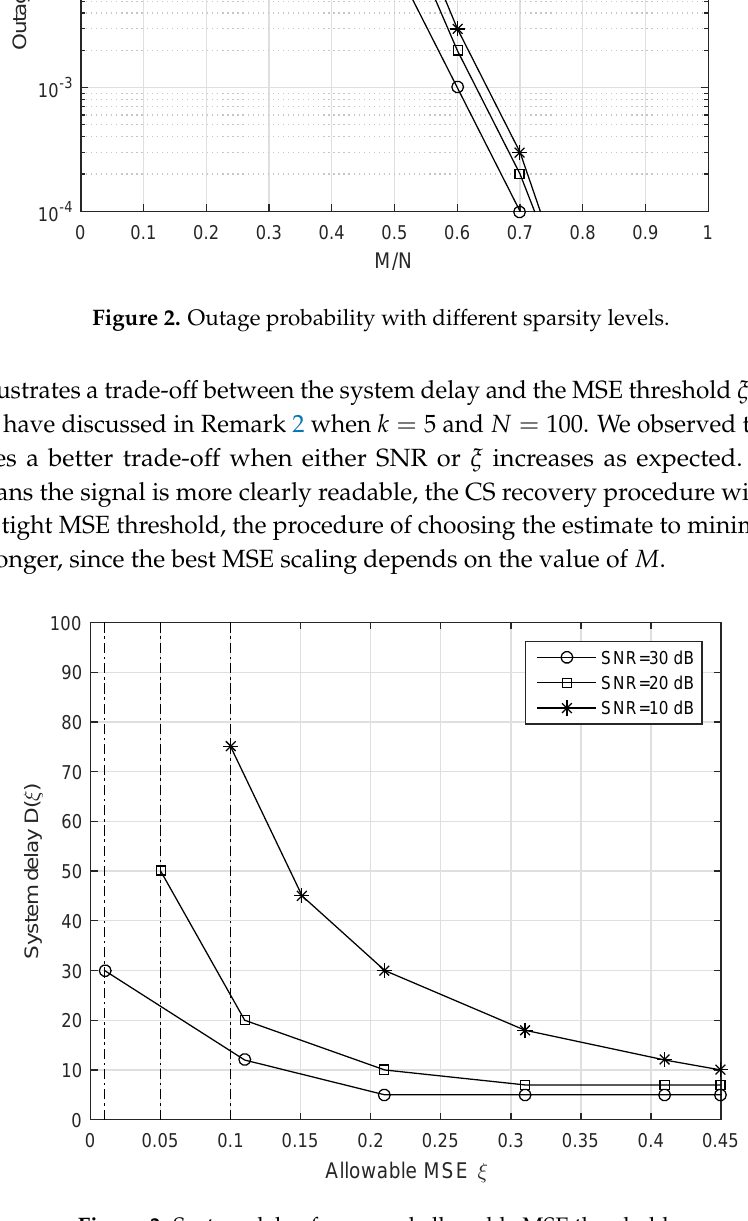
Figure 3. System delay for several allowable MSE